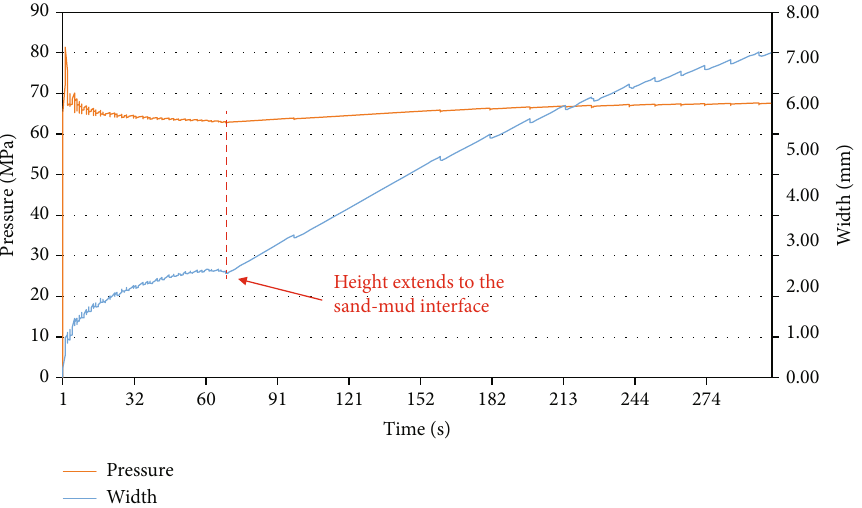
Figure 6: The responses of injection pressure and fracture width during height growth in the reservoir without mud interlayers.